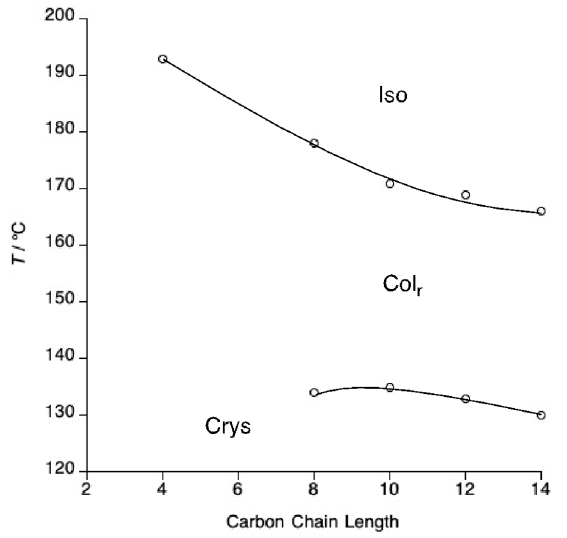
Figure 7. Structure and phase diagram of the tetracatenar triflimide salts, 5 - n .